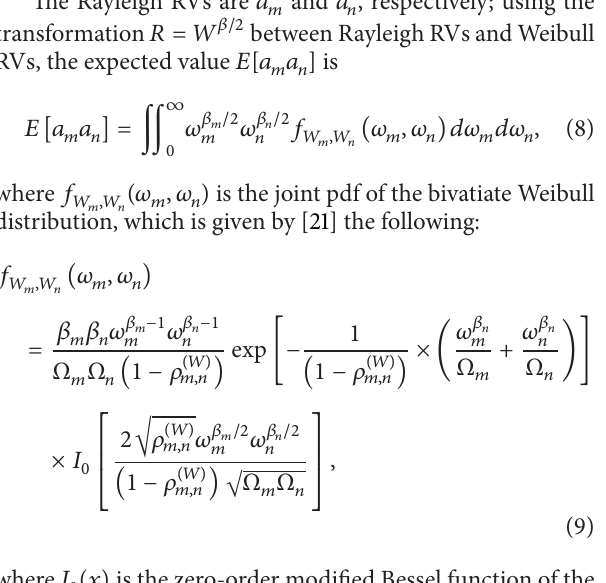
Figure 3: A TDL based non-WSSUS channel